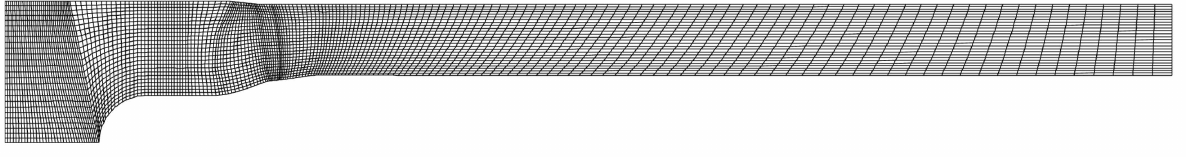
Figure 9. Grid topology of